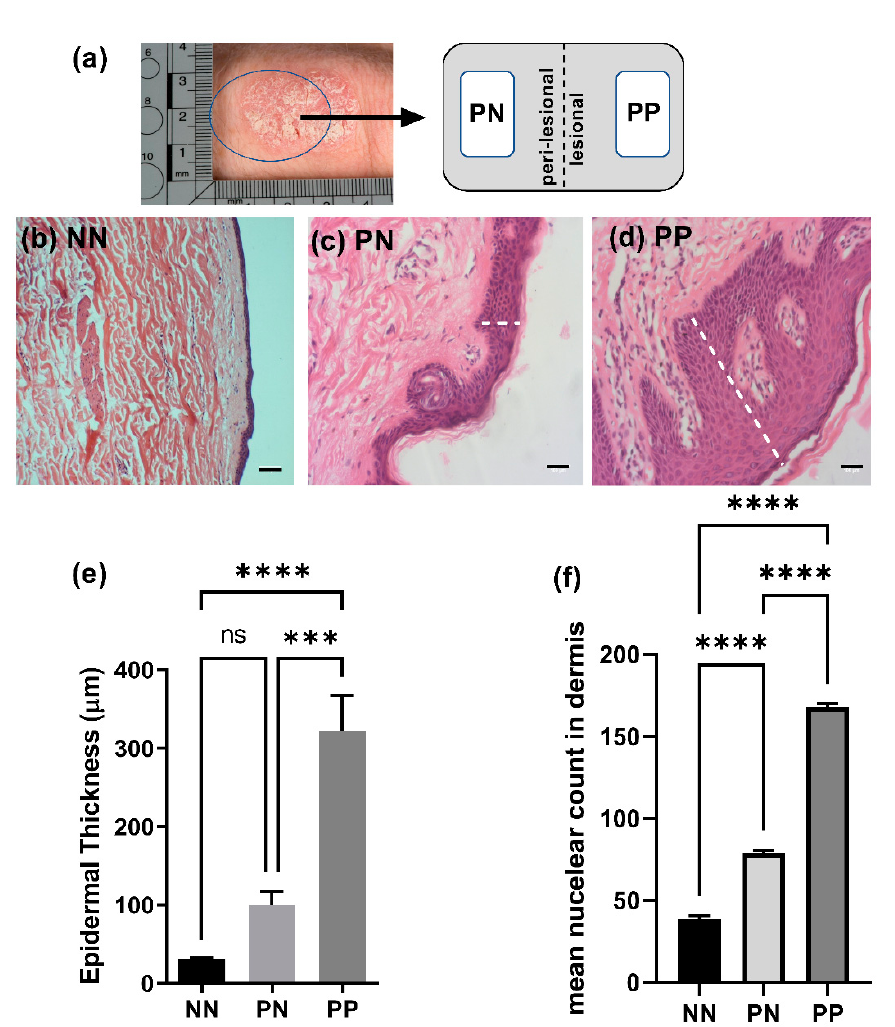
Figure 1. Histological analysis of psoriatic versus normal tissue biopsies. Tissue biopsies were collected from normal donors (NN), psoriatic non-involved (PN) or psoriatic plaque (PP) regions. ( a ) Diagrammatic representation of tissue biopsy sites from PP and PN locations; ( b – d ) representative images of NN, PN and PP biopsies are presented; dotted lines indicate examples of measurements taken; ( e ) epidermal thickness; ( f ) mean dermal nuclear infiltrate. N = 3 donors. Statistical significance was calculated by ANOVA followed by Tukey post-hoc test *** p < 0.005, **** p < 0.0001. Bar = 100 μ m.